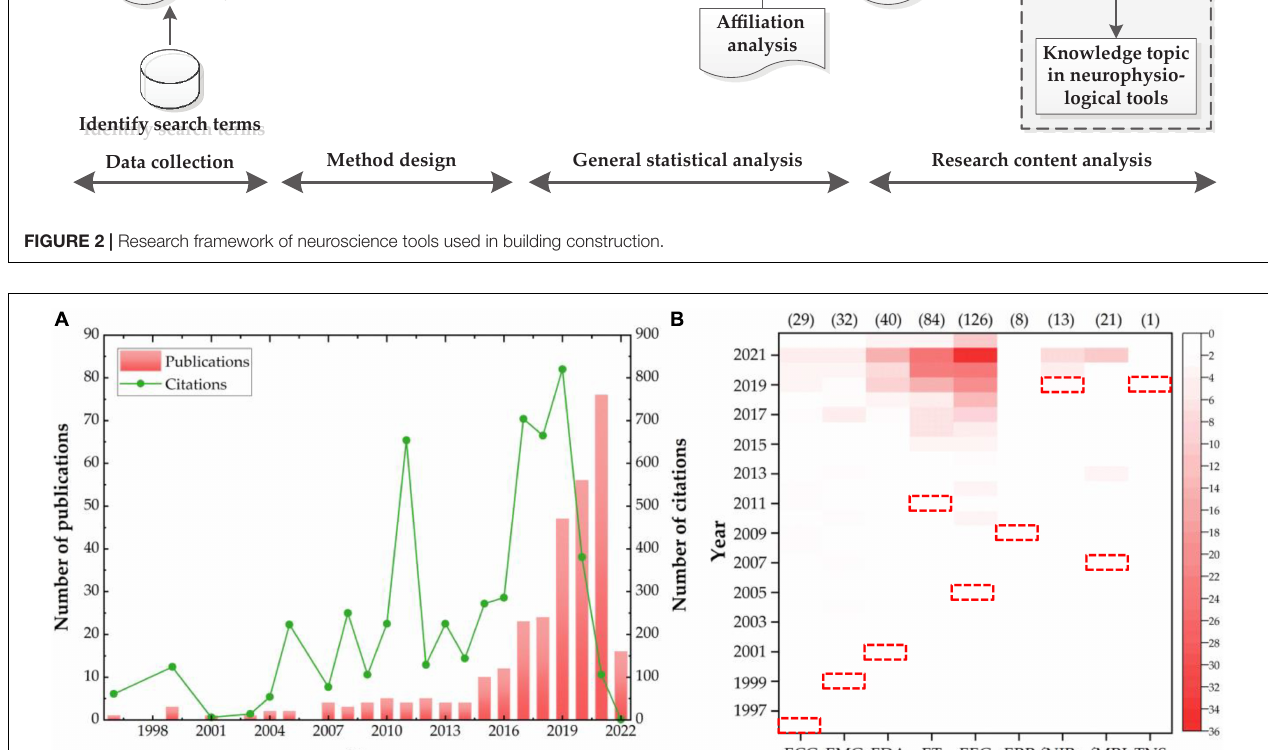
FIGURE 3 | Yearly distribution of publications. (A) Distribution of publications and citations. (B) Distribution of tools in neuroscience.